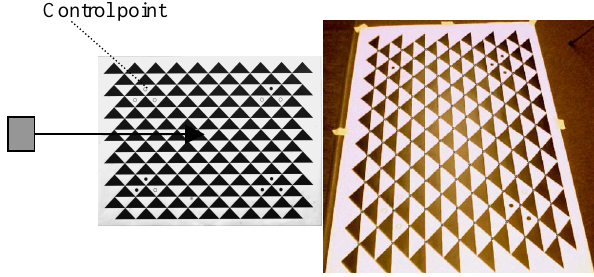
Fig 1 . Calibration grid with control points and taking middle right vertical photo sets